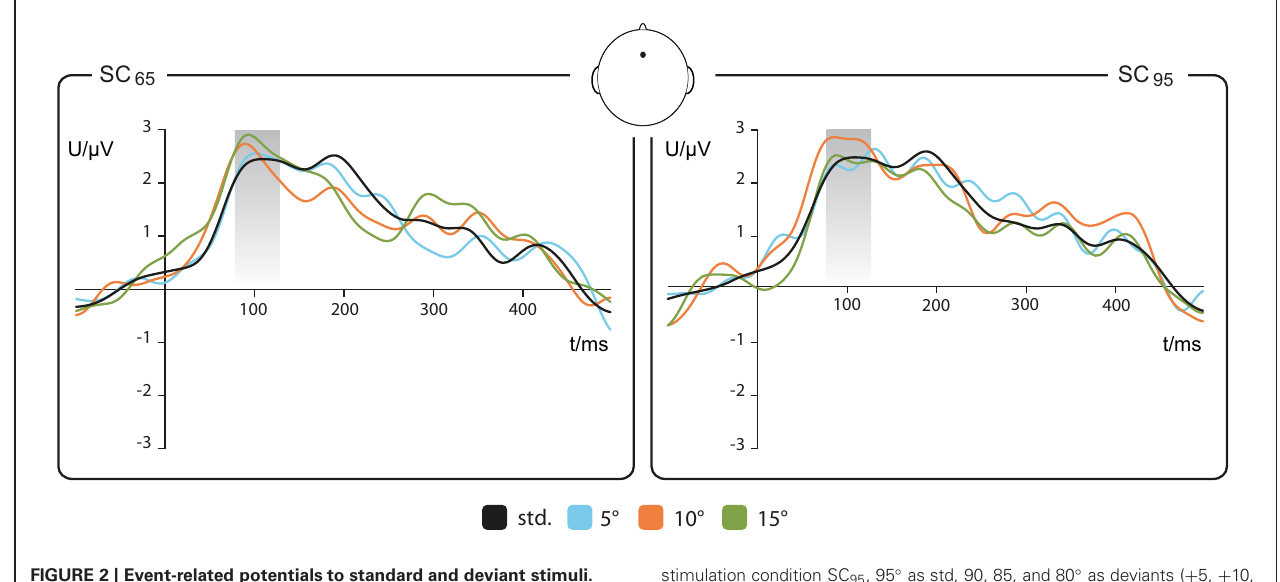
stimulation condition SC 95 , 95 ◦ as std, 90, 85, and 80 ◦ as deviants ( + 5, + 10, and + 15 ◦ deviation relative to std). Shadowed box depicts the (80–130 ms) N1 time window. The running t -test yielded no significant differences between standard and deviants ( n =